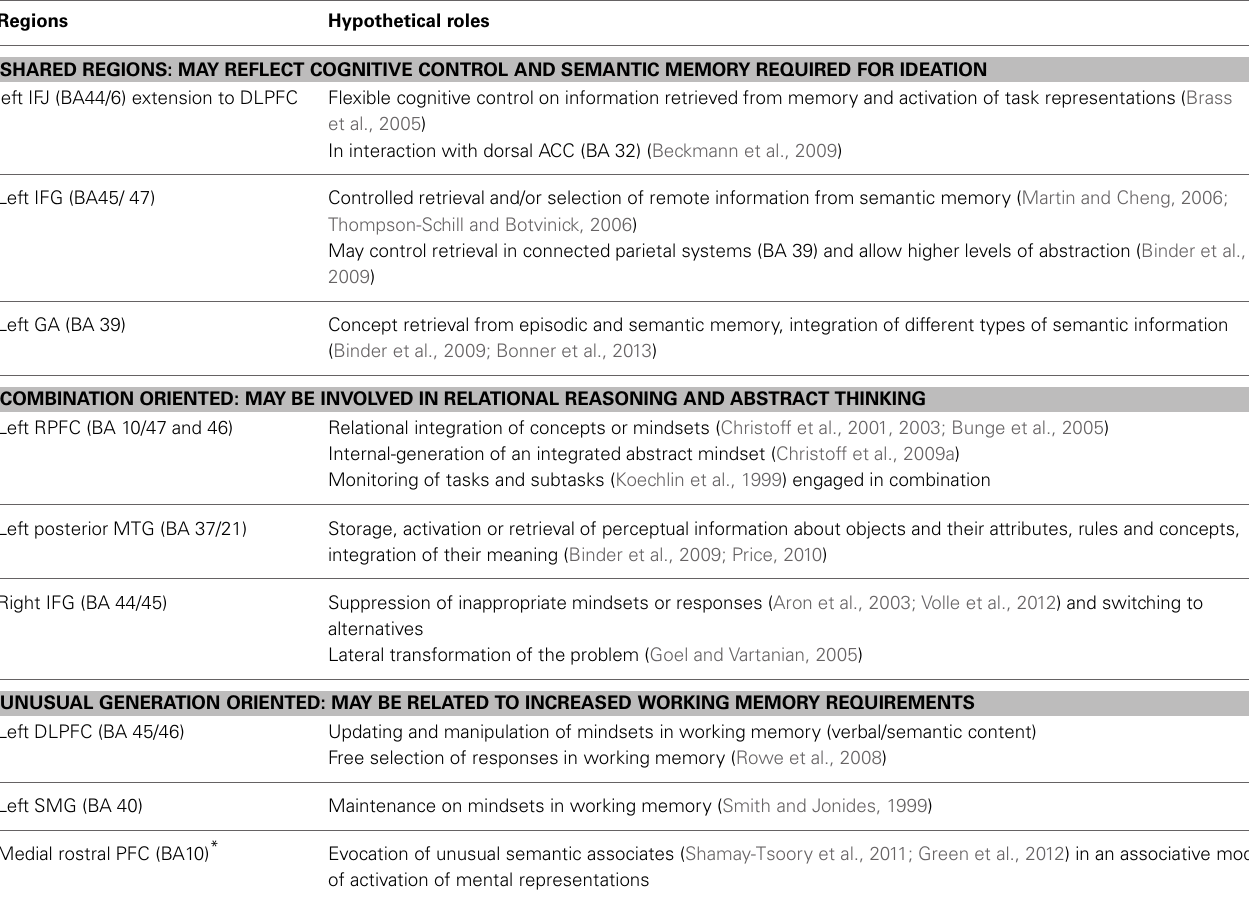
Table 9 | Summary table of the results and hypothetical roles of shared and task-oriented creativity regions. Regions Hypothetical